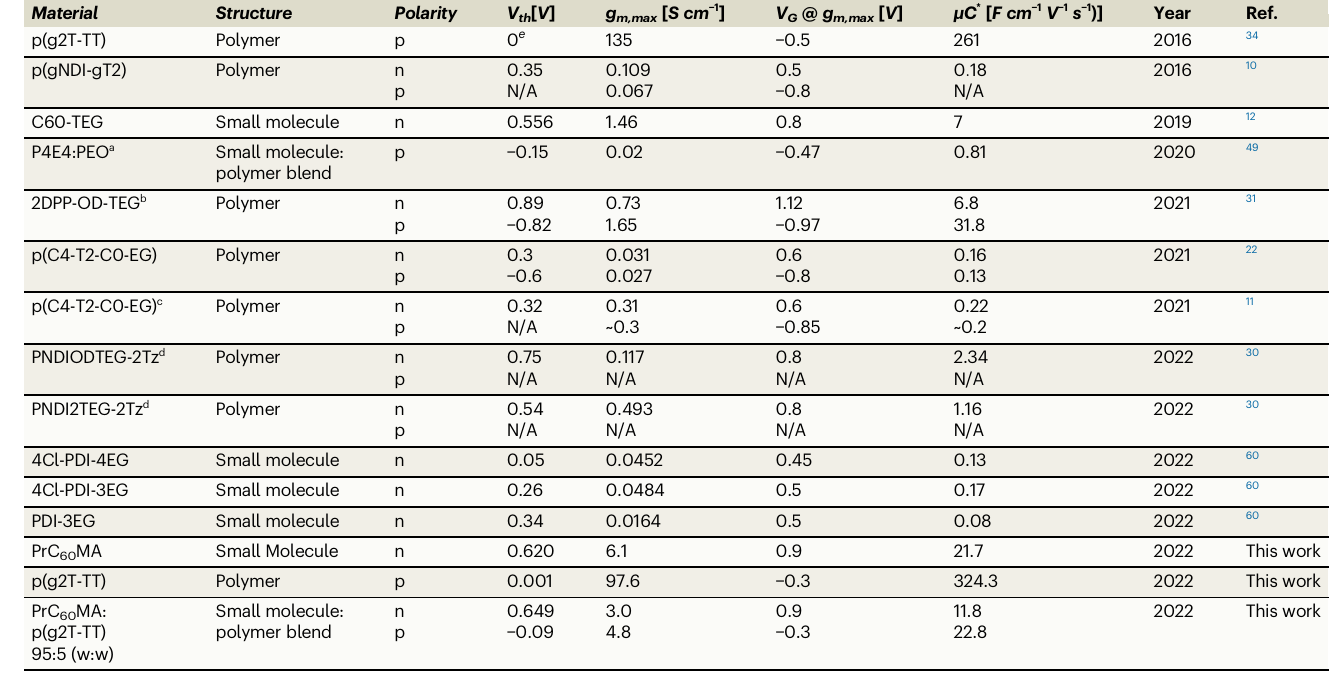
Table 1 | Summary of reported small molecule and ambipolar OECT performances